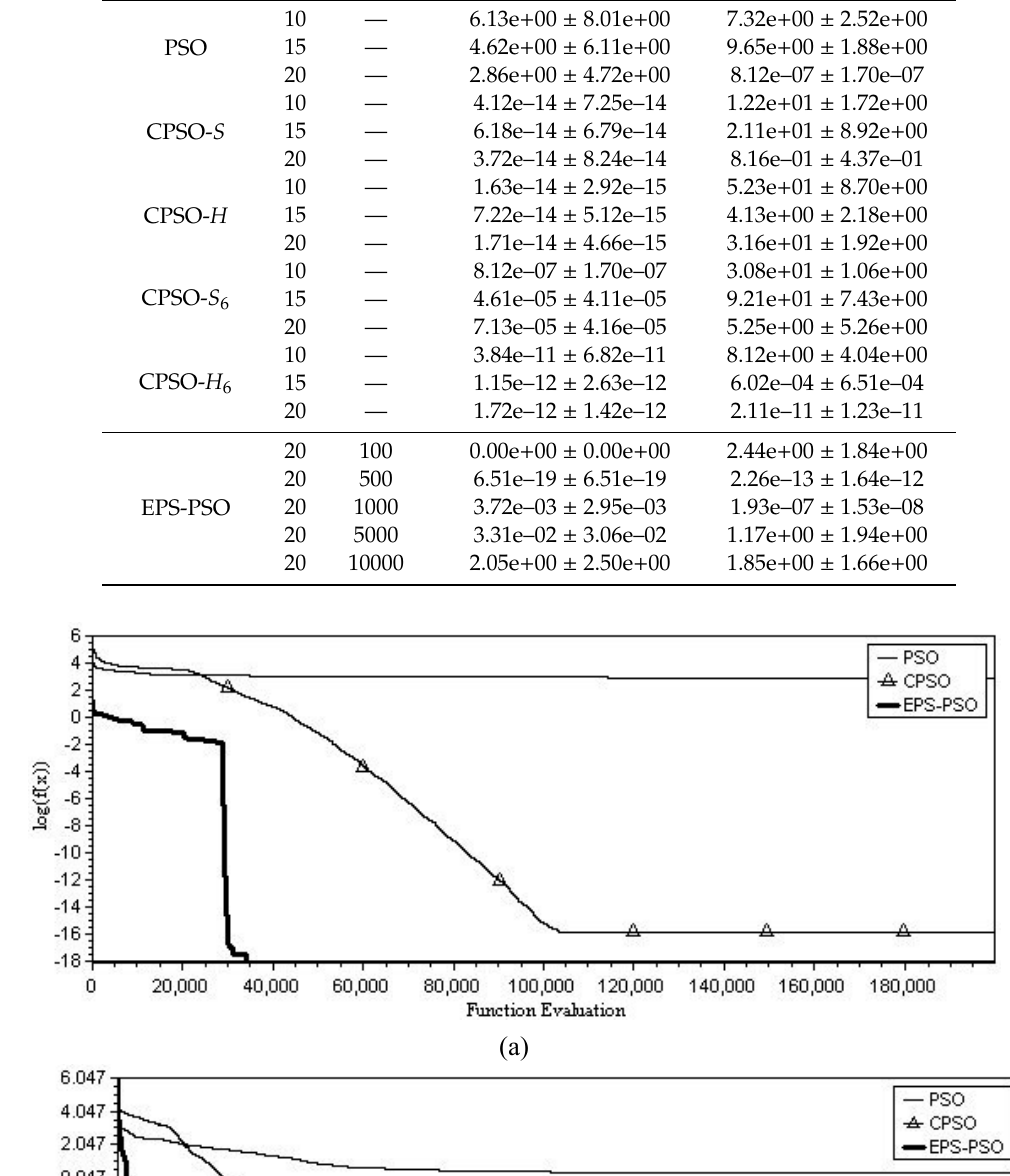
Table 4. Computational results of Ackley obtained by using 6 PSO-based algorithms after 2 × 10 5 function evaluations, averaged over 50 independent runs.